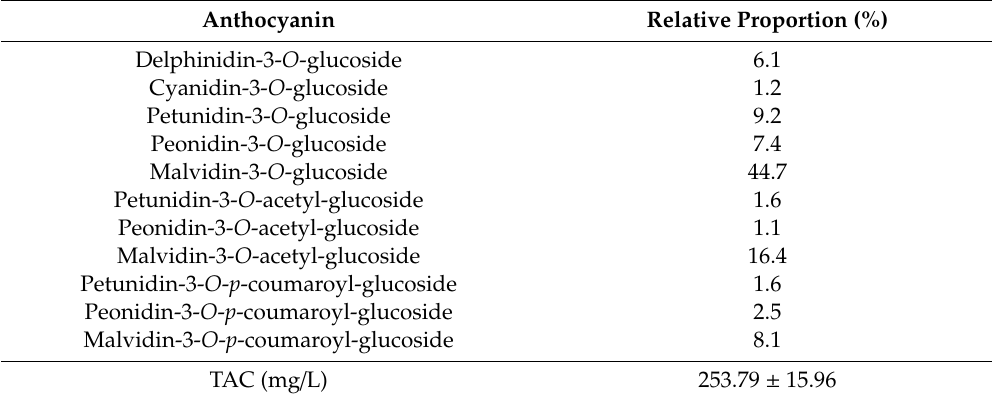
Table 3. Total anthocyanin content and distribution of anthocyanins identified by HPLC / MS in the skins’ anthocyanin extract from red grapes.